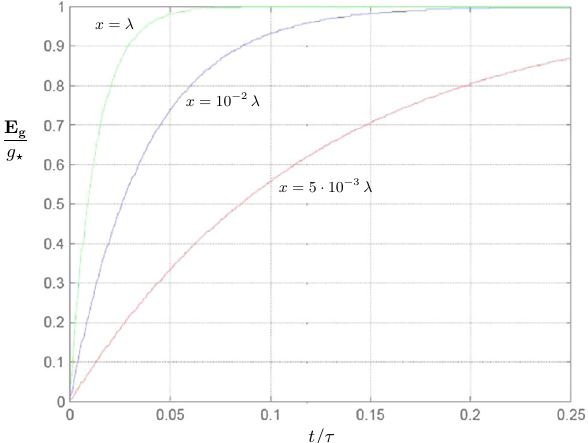
Fig. 4 The gravitational field as a function of the normalized time for increasing values of the x variable for Pb